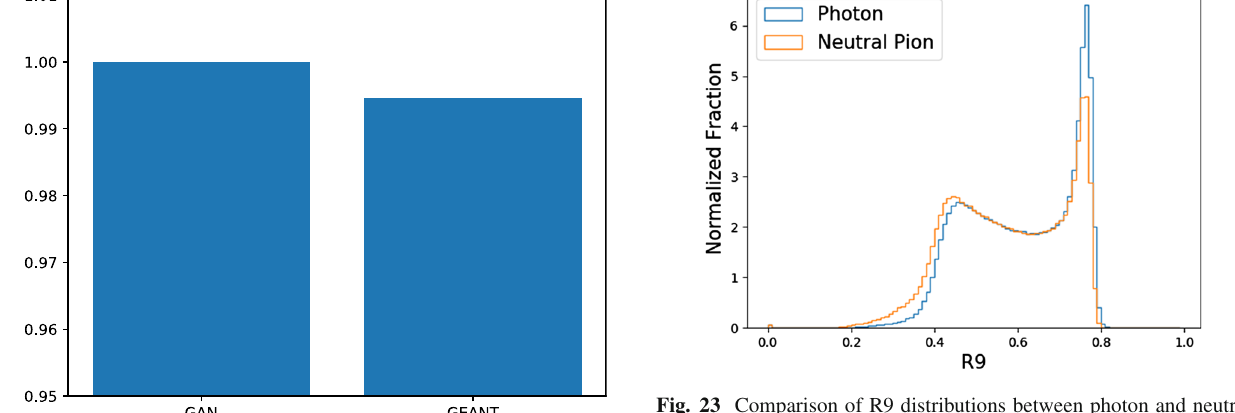
Fig. 23 Comparison of R9 distributions between photon and neutral pion events. Photons tend to have more centralized energy deposition